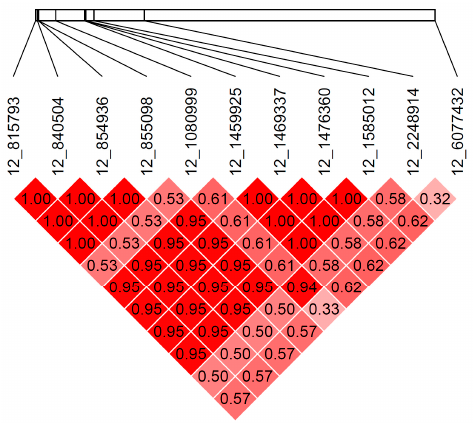
Figure 4. Chromosome 12 linkage disequilibrium matrix showing pairwise r-squared values for the imputed genotypes of 82 unrelated Bearded Collies at 11 variants of interest. Variants are labeled by chromosome and location, as defined by the CanFam3.1 reference genome. Image generated using the R package gaston. The intensity of red corresponds to the r-squared value, with deeper red indicating greater r-squared values.